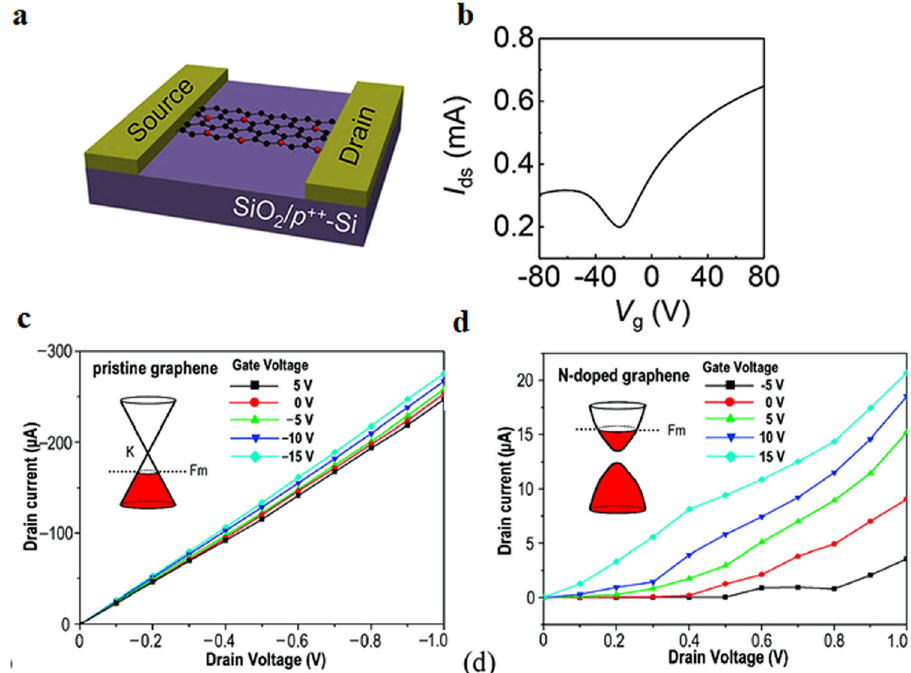
Fig. 8 Electrical properties. a , b Schematic of a fi eld-effect transistor (FET) device and I – V g characteristics of a NDG-based FET (reproduced from 26 with permission from Elsevier); c , d I ds versus V ds plots of graphene and NDG FET devices for various V g , where V g , I ds , and V ds denote the gate voltage, source-drain current, and source-drain voltage, respectively. Insets at the upper left of panels c and d are the presumed band structures of graphene and NDG FET devices, respectively (reproduced from 56 with permission from the American Chemical